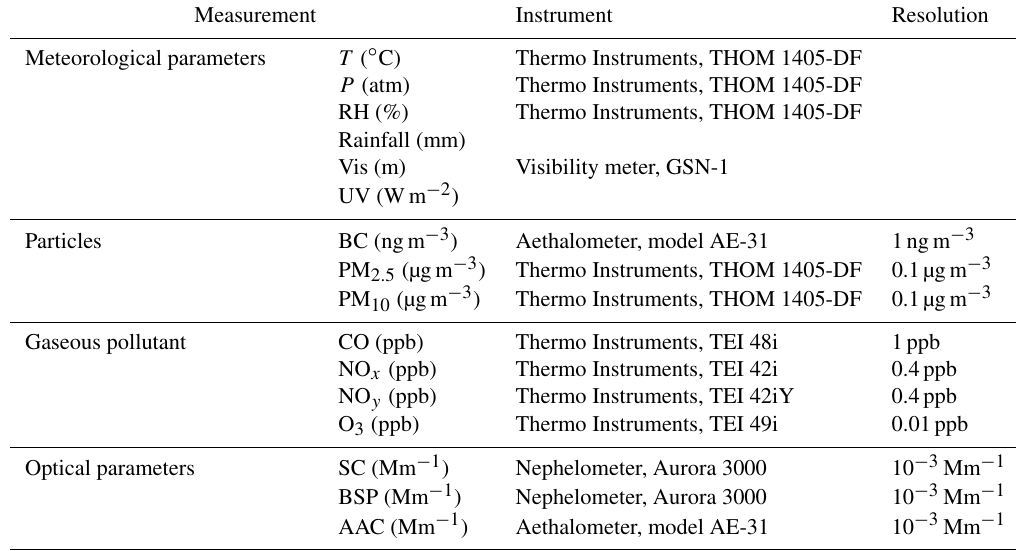
Table 1. Measurements at the Gulou site.